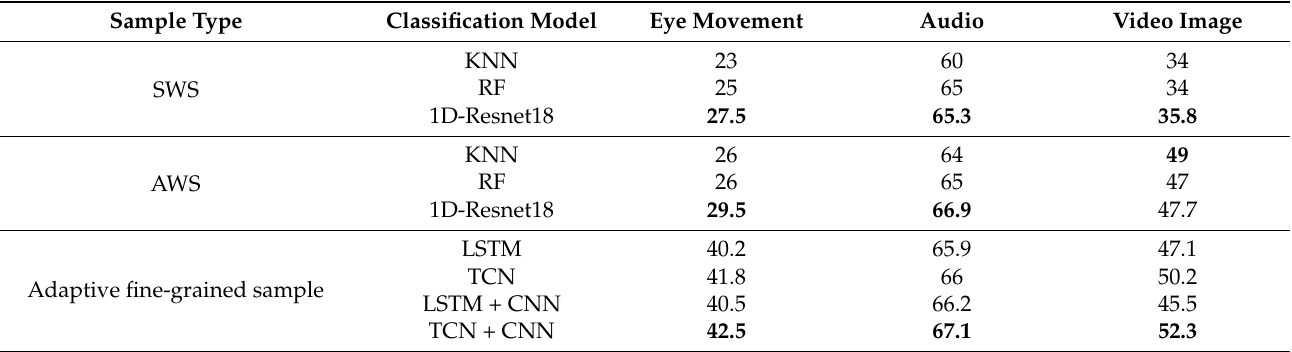
Table 5. Recognition effects of different models with 3 s SWS, AWS ( n = 90) and fine-grained samples.